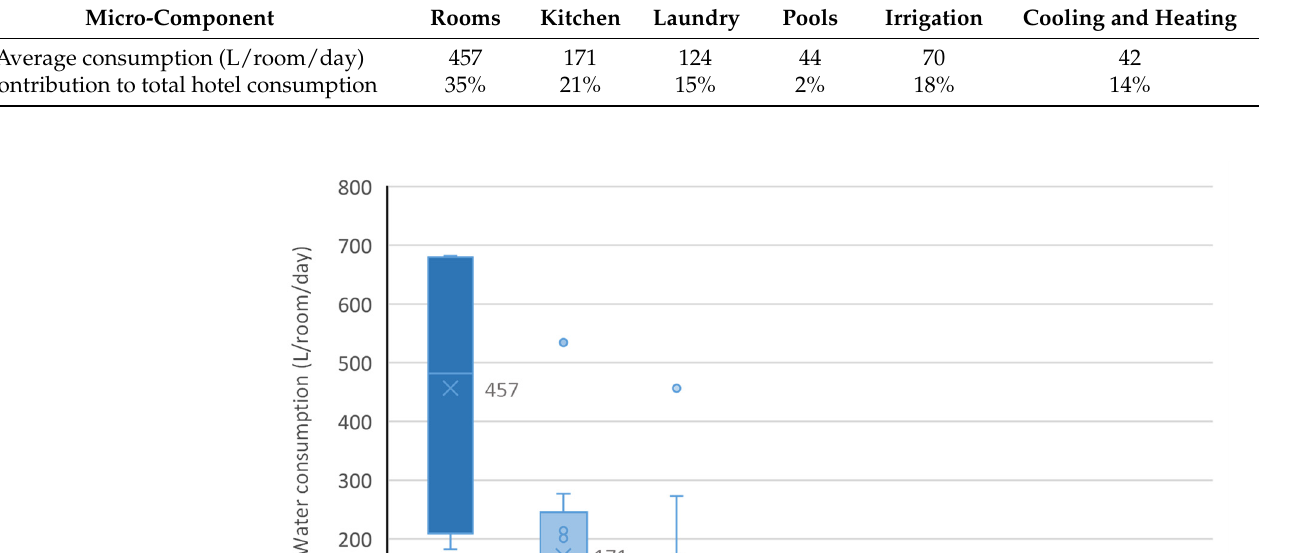
Table 2. Average daily water consumption for each micro-component.